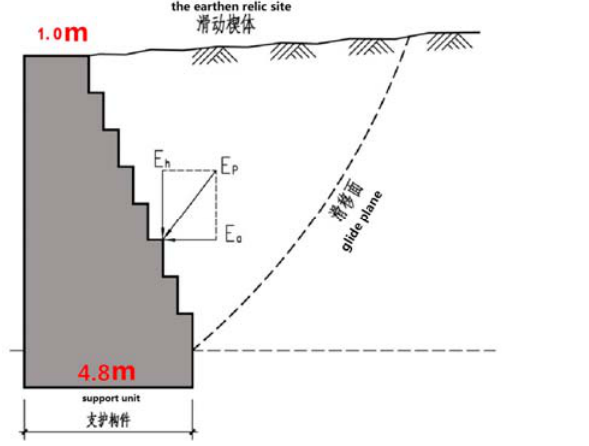
Figure 10. The analysis chart of structural stress